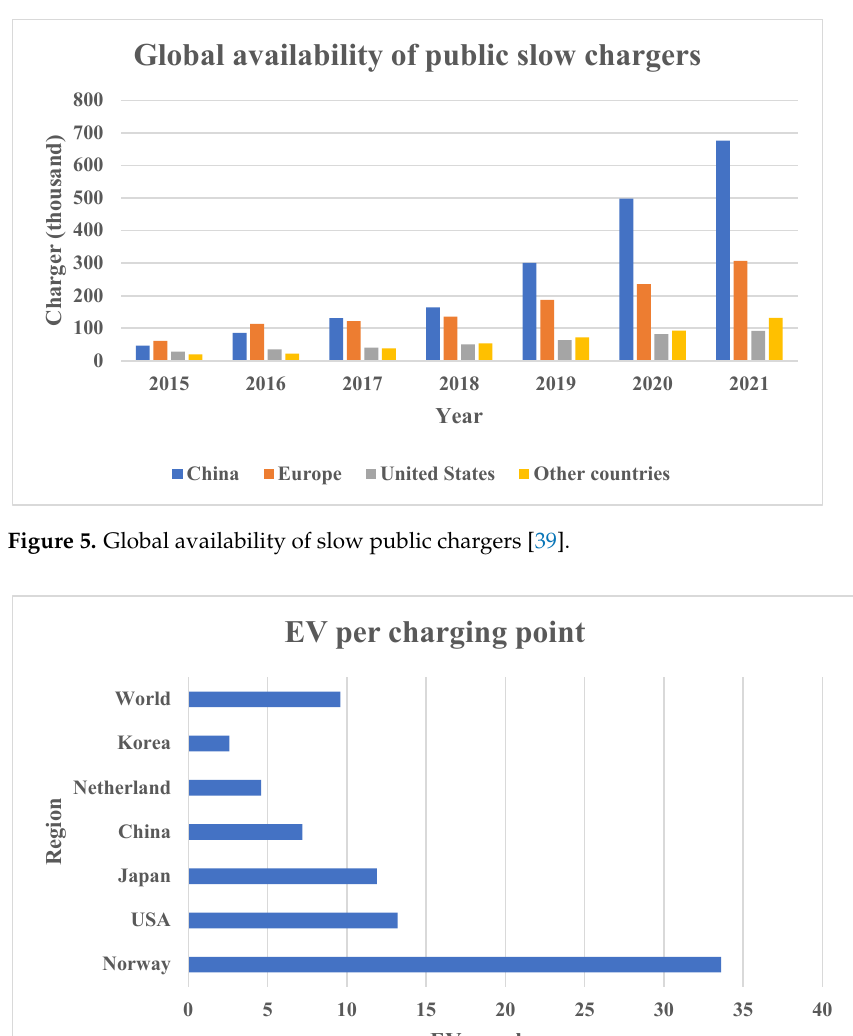
Figure 4. Global availability of fast public chargers [39].